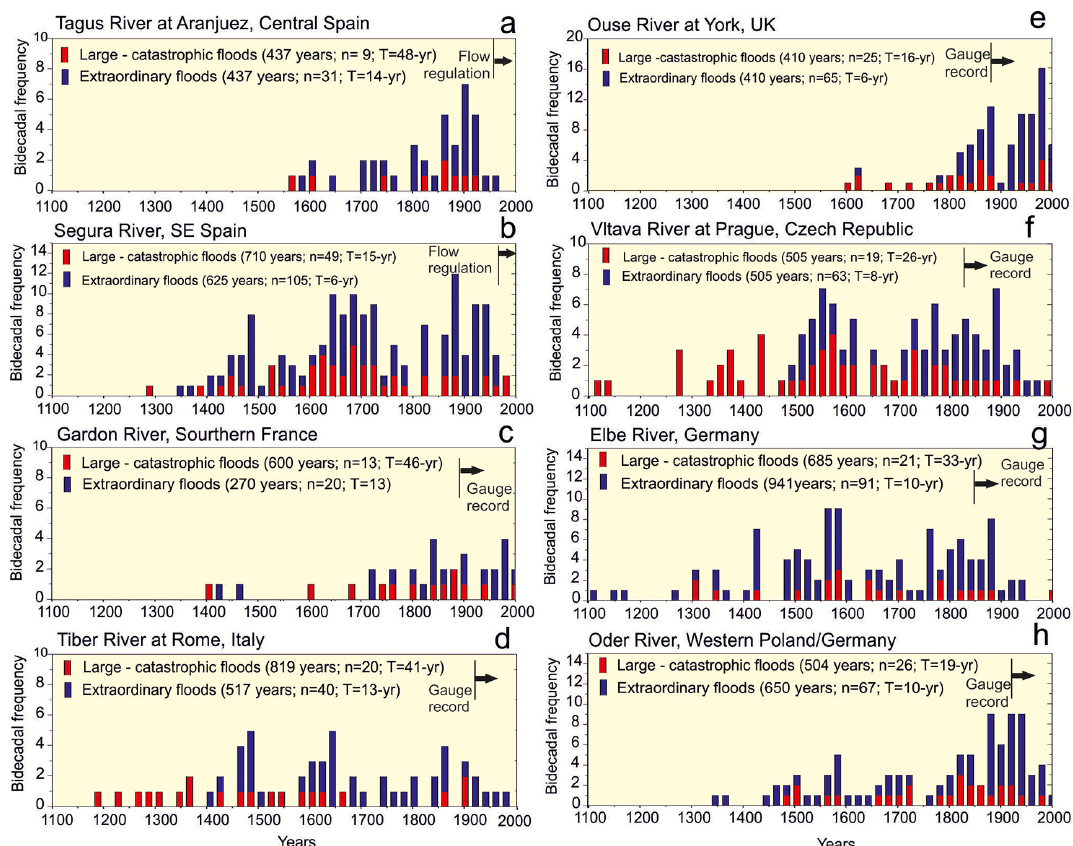
Figure 8. Bi-decadal (20-year) flood frequency based on documentary and instrumental records in the selected European rivers (floods exceeding a particular discharge threshold or height). Two flood categories were differentiated: catastrophic floods (CAT) associated with high flood discharge or severe damages, and extraordinary floods (EXT) causing inundation of the floodplain with moderate-to-minor damages. The length of record in years, number of recorded floods ( n ), and the mean occurrence interval ( T in years) for each category and river are indicated. (a) The River Tagus in Aranjuez, documentary and instrumental data, CAT: > 400m 3 s − 1 , EXT: 100–400m 3 s − 1 (Benito et al., 2003a; Machado et al., 2015). (b) Segura-Guadalentín rivers at Murcia (Barriendos and Rodrigo, 2006; Machado et al., 2011). (c) The River Gardon, documentary data since the 15th century, historical and daily water-level readings at Anduze (1741–2005; Neppel et al., 2010), CAT: > 3000m 3 s − 1 ; EXT: 1000–3000m 3 s − 1 ; complemented with discharges from palaeofloods at La Baume (Sheffer et al., 2008). (d) The River Tiber in Rome, observed historical levels since the 12th century, continuous water-level readings since 1870 at the Ripetta Landing (Calenda et al., 2005), CAT: > 2900m 3 s − 1 (flood level > 17m at Ripetta), EXT: 2300–2900m 3 s − 1 . (e) The River Ouse, documentary and instrumental data (Macdonald and Black, 2010), CAT: > 500m 3 s − 1 , EXT: 350–500m 3 s − 1 . (f) The River Vltava in Prague, documentary and instrumental data (Brázdil et al., 2005a), CAT: Q > 2900m 3 s − 1 or a flood index 2 and 3, EXT: 2000–2900m 3 s − 1 or flood index 1. (g) The Elbe River, documentary and instrumental date (Mudelsee et al., 2003); classes refer to Mudelsee et al. (2003) strong (EXT) and exceptionally strong (CAT) flooding. (h) The Oder River, documentary and instrumental data (Mudelsee et al., 2003). Data before AD 1500 are incomplete due to a lack of documentary evidence. Modified from IPCC